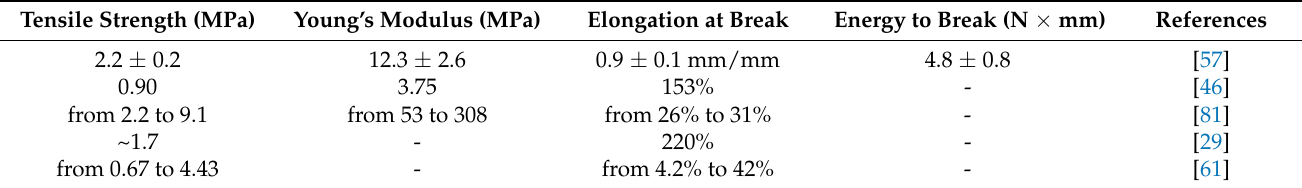
Table 5. Mechanical properties of PVC nanofiber mats.